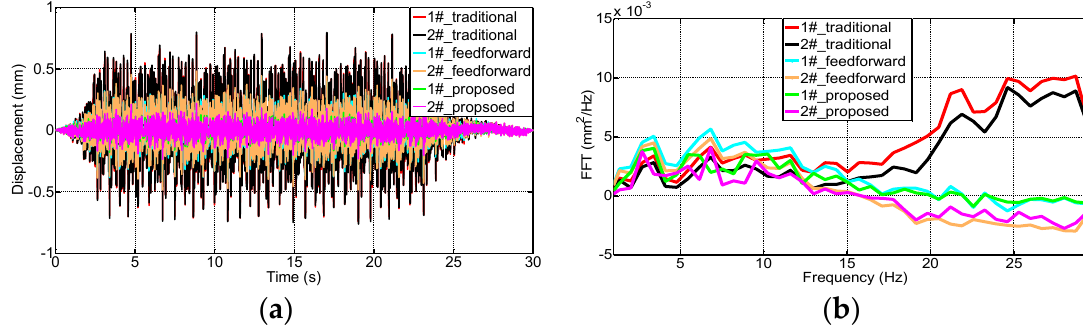
Figure 25. Tracking errors under random signal. ( a ) Time domain; ( b ) Frequency domain. Table 6. Tracking errors under random signal.